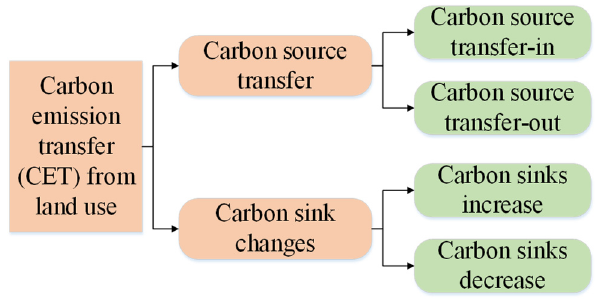
Figure 1. Connotation of carbon emission transfer from land use.